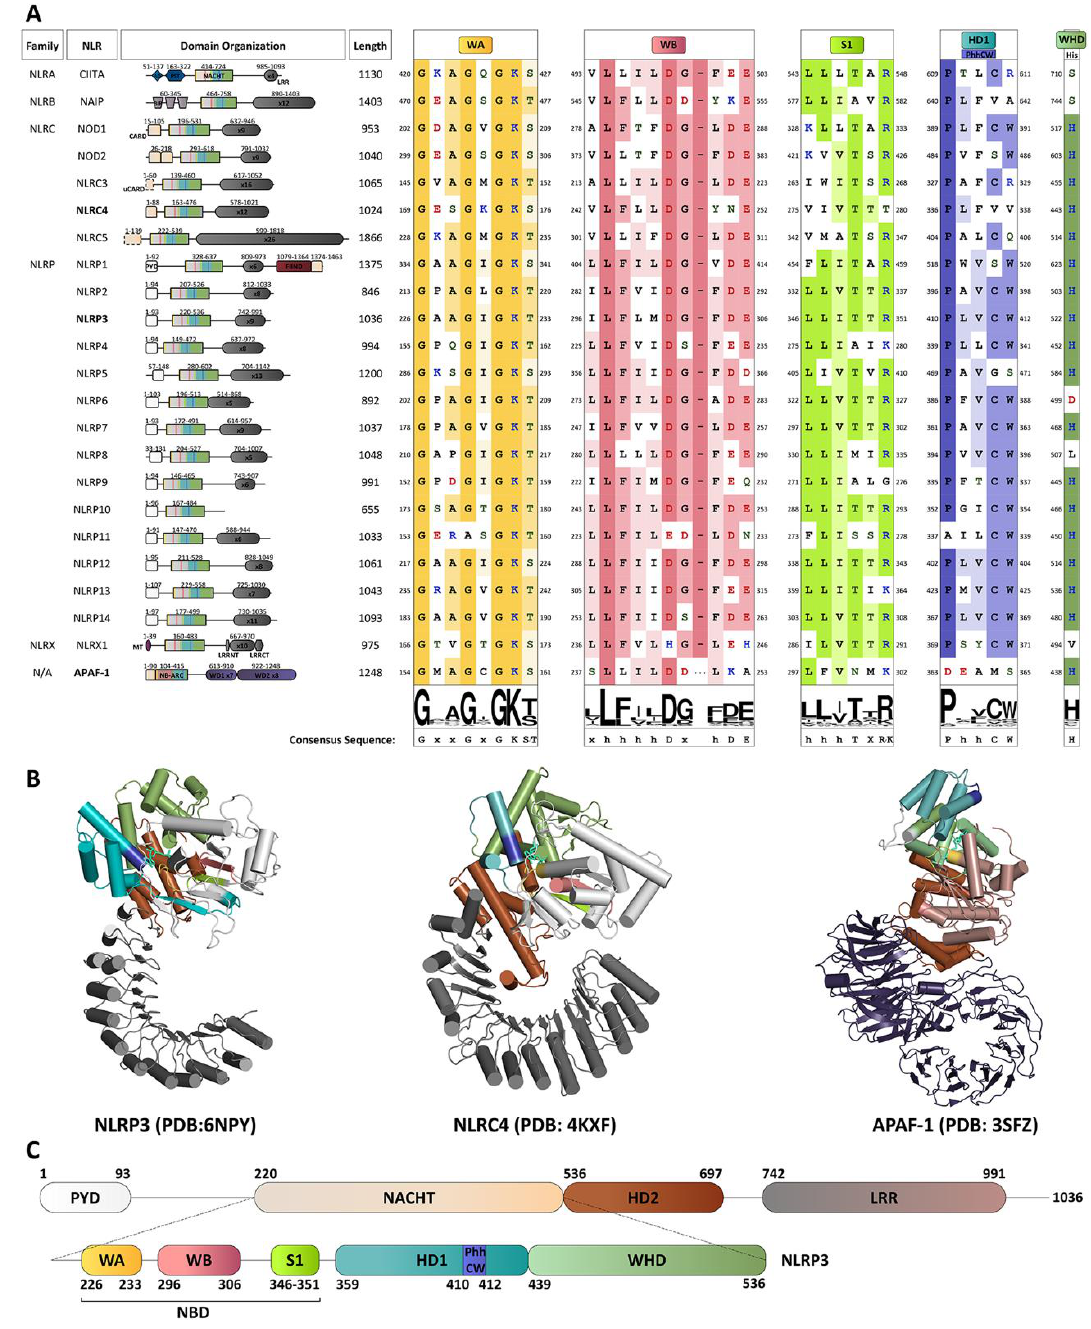
Figure 1. Characterization of NLRP3 and the NLR family. ( A ) Multiple sequence alignment of conserved features critical for catalytic activity in the 22 NLR proteins and APAF-1 NBD motifs. The NLR family members are subdivided based on the presence of one of four N-terminal effector domains: NLRAs with an acidic domain (AD), NLRBs with a Baculovirus IAP repeat (BIR), NLRCs with a caspase recruitment domain (CARD), or NLRPs with a pyrin domain (PYD). The naming system approved by the HUGO Gene Nomenclature Committee (HGNC) is used [10]. Domain identities and configuration for NLR proteins are displayed to scale with boundaries numbered as per UniProtKB accession numbers: CIITA, P33076; NAIP, Q13075; NOD1, Q9Y239; NOD2, Q9HC29; NLRC3, Q7RTR2; NLRC4, Q9NPP4; NLRC5, Q86WI3; NLRX1, Q86UT6; NLRP1, Q9C000; NLRP2, Q9NX02; NLRP3, Q96P20; NLRP4, Q96MN2; NLRP5, P59047; NLRP6, P59044; NLRP7, Q8WX94; NLRP8, Q86W28; NLRP9, Q7RTR0; NLRP10, Q86W26; NLRP11, P59045; NLRP12, P59046; NLRP13,